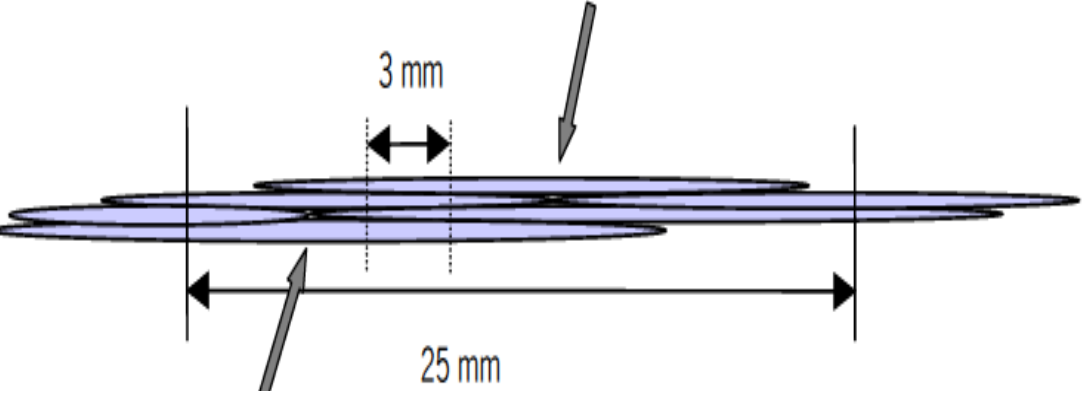
Figure 3. Schematic representation of failure mechanism of flax fibres. At 25 mm clamping length, elementary fibres slip over each other. At 3 mm, cracks run through the cross section of the elementary fibres. Adapted with permission from [16]. Copyright 2013 by Eindhoven